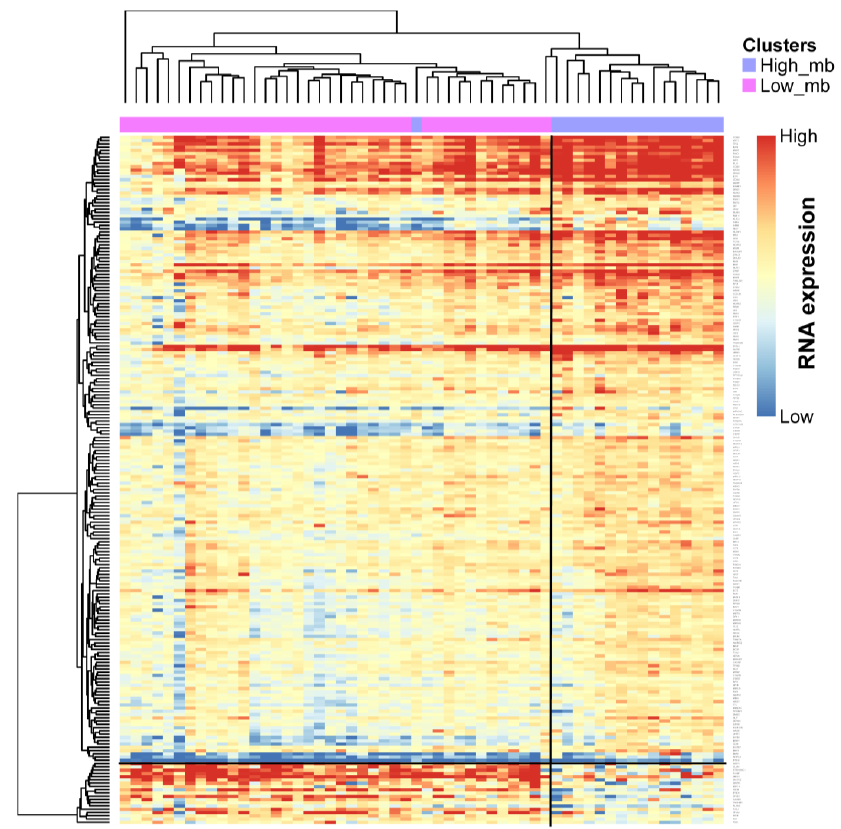
Figure 7. Unsupervised hierarchical clustering of 56 patients identifies two mRNA clusters / groups. The TMB feature is indicated by the annotation bars above the